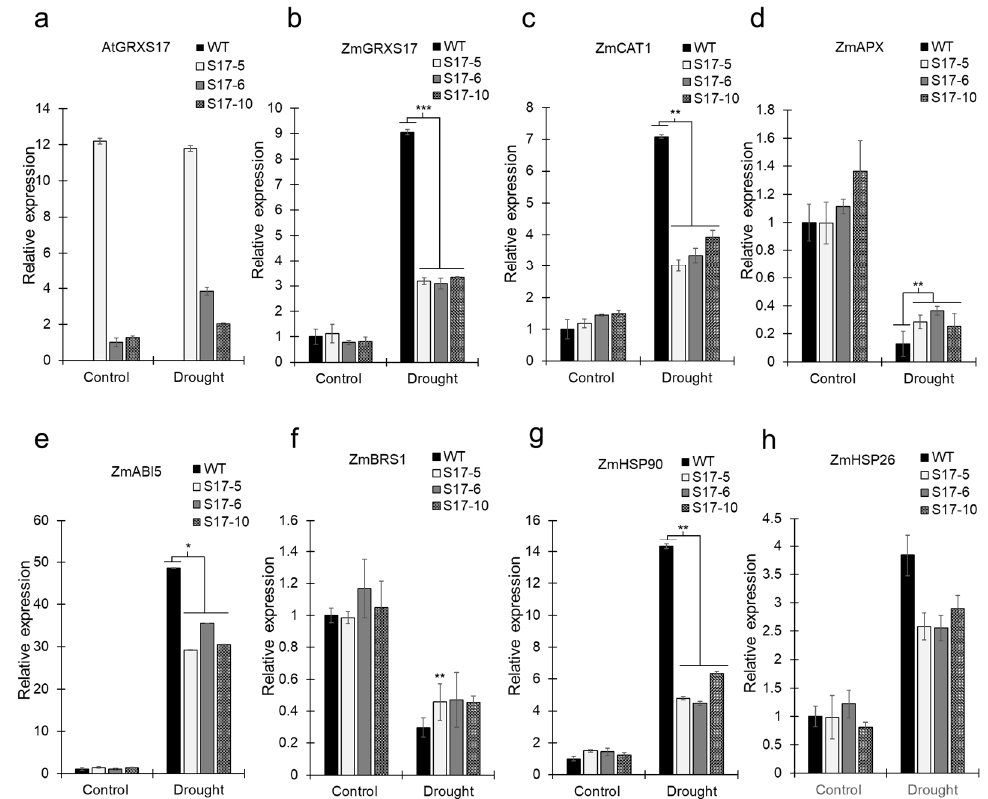
Figure 5. A relative comparison of transcript levels between AtGRXS17- expressing and WT maize plants in response to drought stress; ( a ) AtGRXS17 ; ( b ) ZmGRXS17 ; ( c ) Catalase ( ZmCAT1 ); ( d ) L- ascorbate peroxidase ( ZmAPX ); ( e ) ABSCISIC ACID-INSENSITIVE 5 ( ZmABI5 ); ( f ) Brassinosteroid synthesis 1 ( ZmBRS1 ); ( g ) Heat shock protein, 90 KDa ( ZmHSP90 ); ( h ) Heat Shock protein, 26 KDa ( ZmHSP26) . Data were analyzed using one-way ANOVA. Asterisks indicate significance level (* p